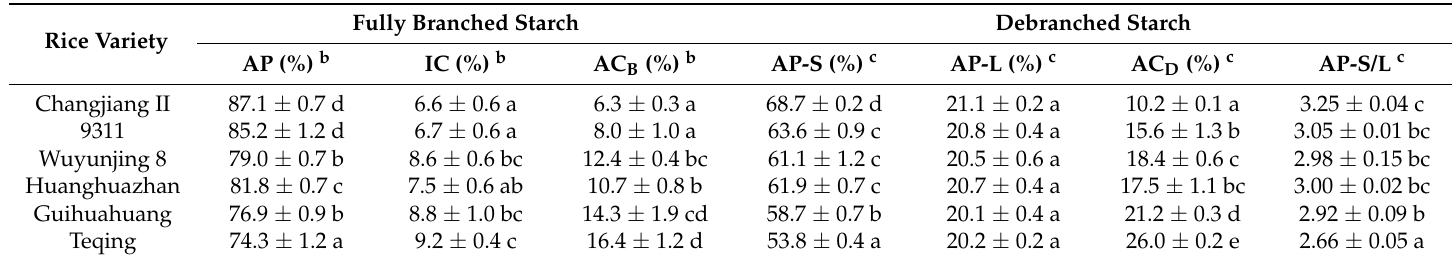
Table 2. Molecular weight distributions of fully branched and debranched starches a .